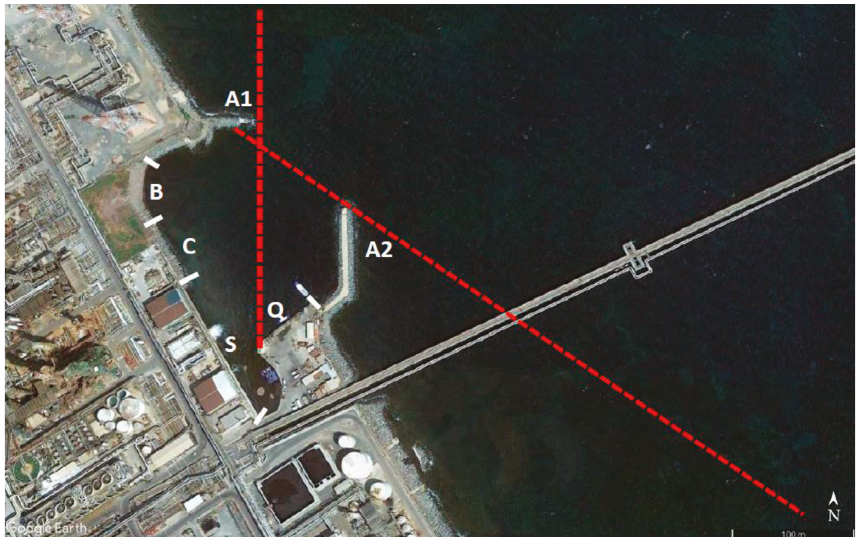
Figure 2: Saras harbor layout (in addition to the text: B: sandy beach; C: rocky revetment; red dotted lines define the portion of the waterfront from where the outer sea can be viewed through the harbor entrance).